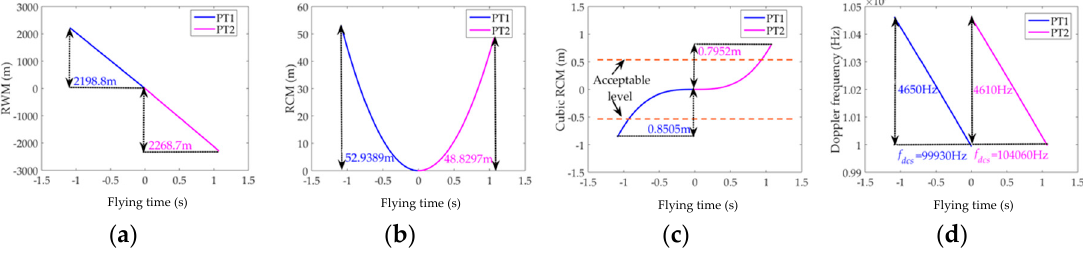
Figure 2. Phase errors for different range models: ( a ) second ‐ order model; ( b ) third ‐ order model; and ( c ) fourth ‐ order model.